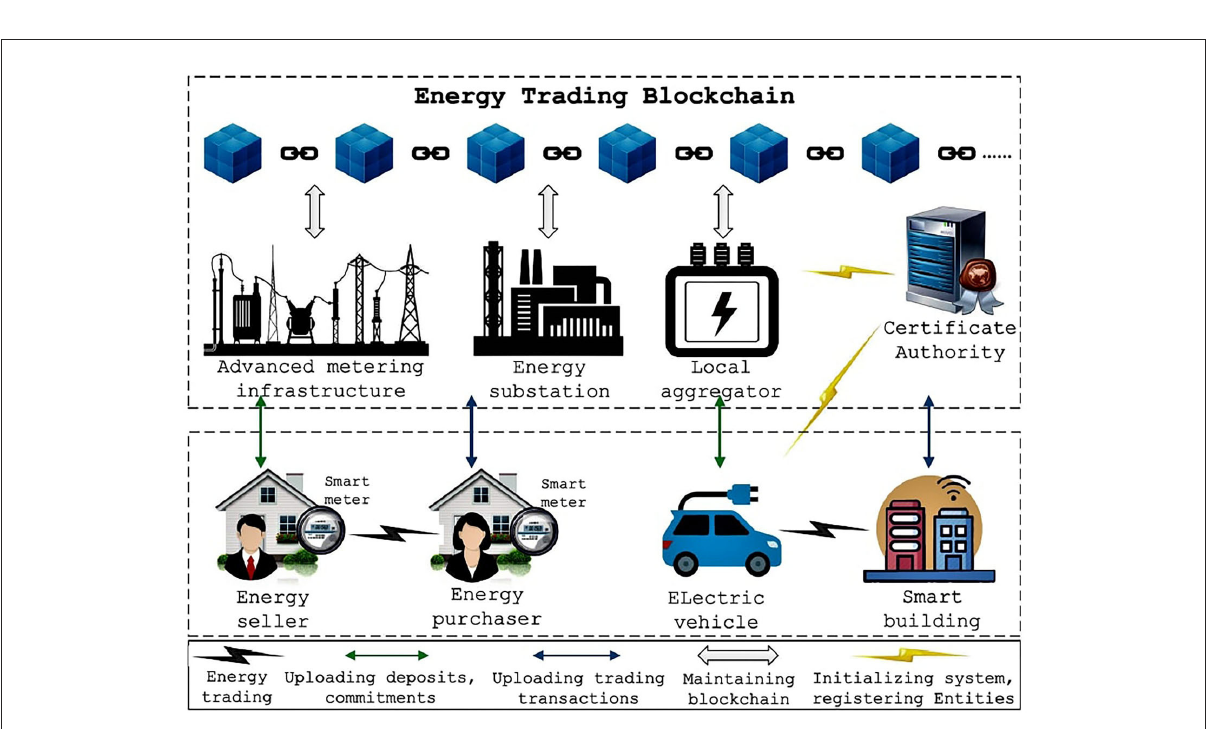
FIGURE13 Proposed model of energy trading blockcahin for IoT (Li et al., 2020b).